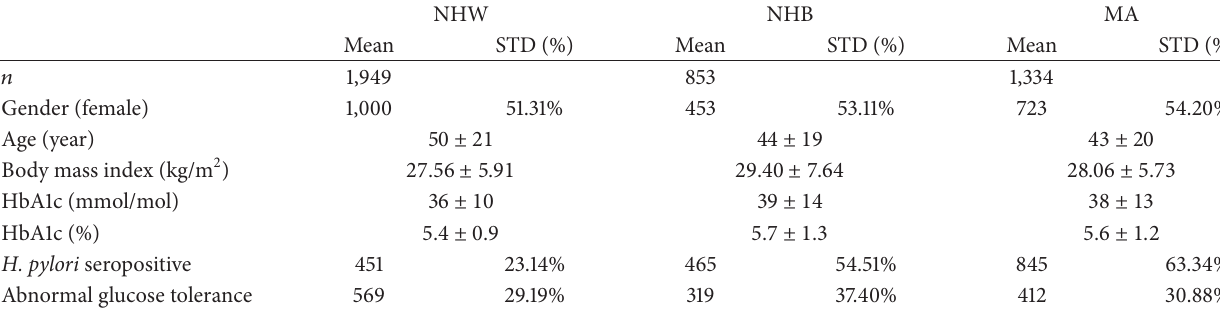
Table 1: Clinical characteristics of studied subjects.